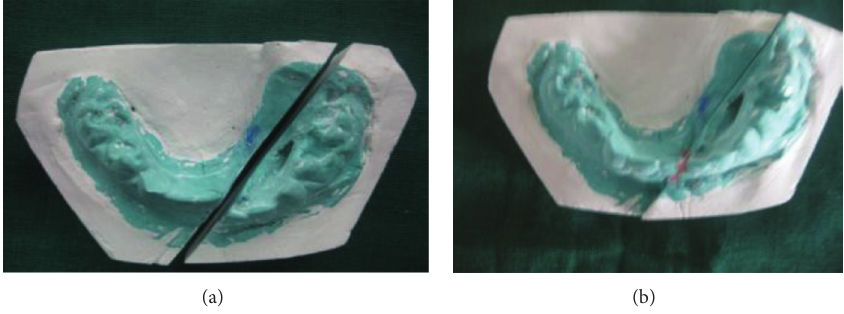
Figure 3: Preoperative model setup.